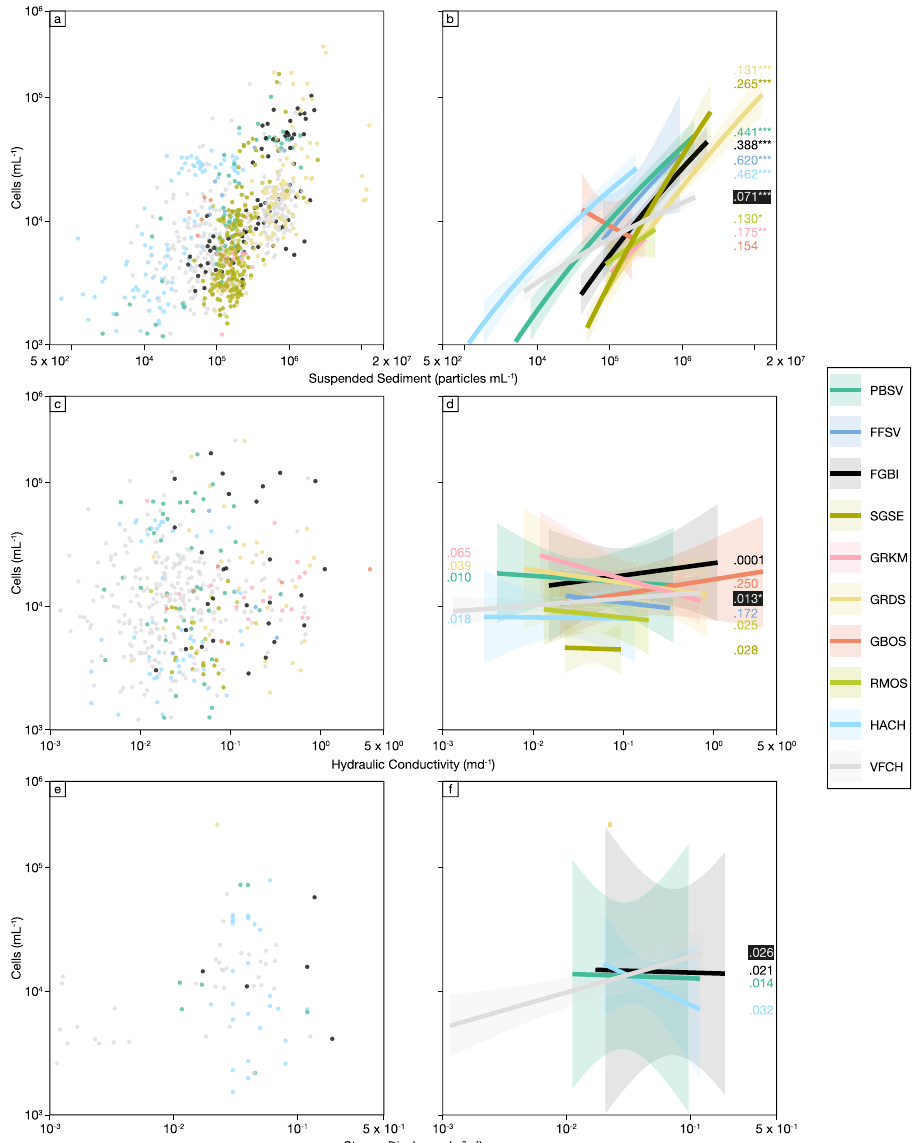
Fig. 4 Associations between cell concentration and related hydraulic variables. a Scatter plot of suspended sediment concentration (particles mL − 1 ) against cell concentration for all samples. b Linear regressions of suspended concentration against abundance for each glacier site. c Scatter plot of hydraulic conductivity ( K ) in m d − 1 against cell concentration for all weathering crust samples. d Linear regressions for C. e Scatter plot of stream discharge ( Q ) in m 3 s − 1 against cell concentration for four glacier settings where measurements n > 5. f Linear regressions for E. For all plots, each glacier ’ s data are colour-coded; for plots b , d , and f the 95% con fi dence limits are shown, and adjusted r 2 values a r e given with signi fi cance indicated by * for p < 0.1, ** for p < 0.05, and *** for p < 0.01. Note that r 2 values for VFCH are presented with a black background for visual